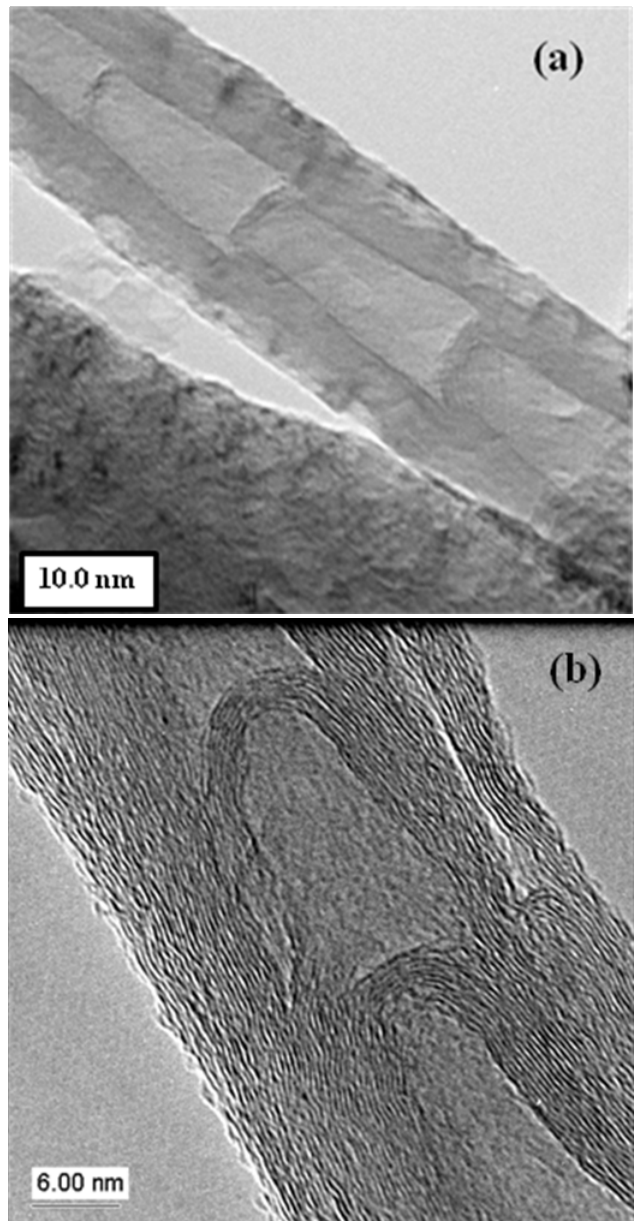
pyrolysis of toluene and ferrocene in the presence of 8% diethylamine. (Letsoala, P.J.; Cele, L.M.; Nxumalo E.N.; Coville, N.J. The influence of nitrogen sources on